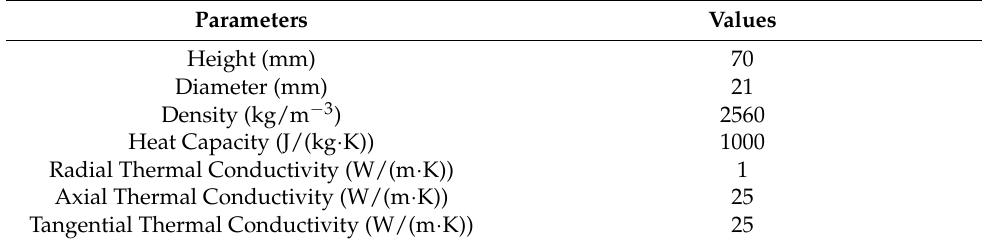
Table 1. The basic parameters of the battery used in the study.